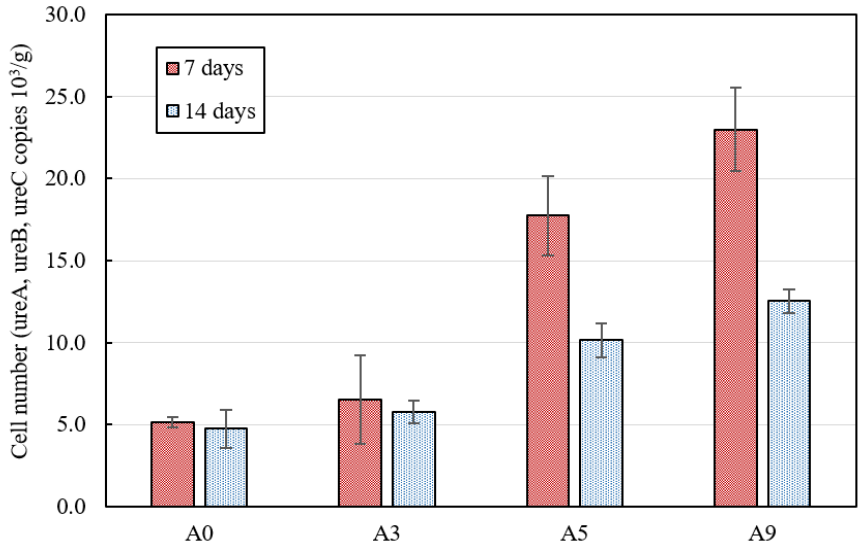
Figure 2. Viability of S. pasteurii in the paste specimens on the 7th and 14th days.